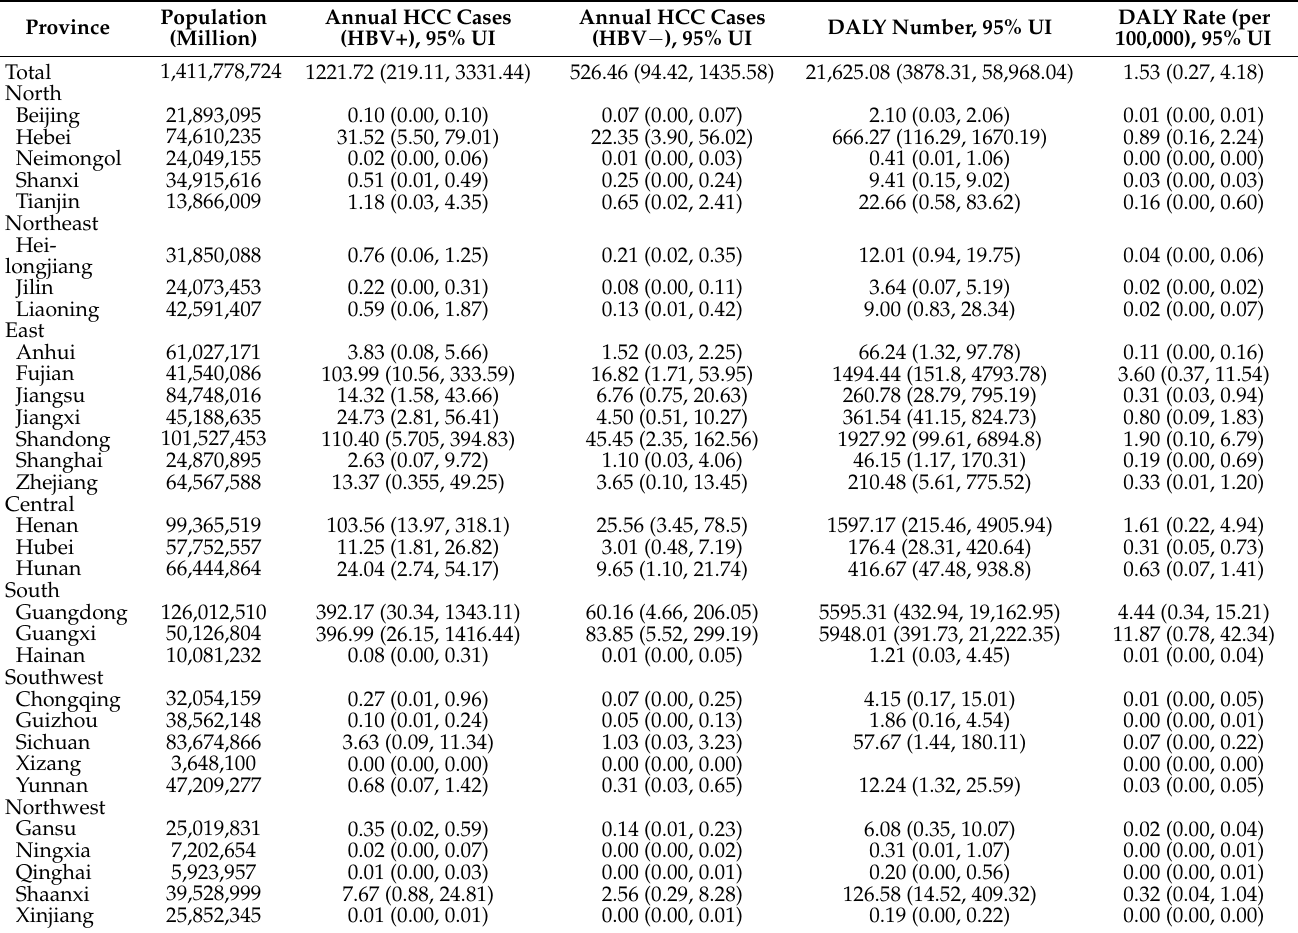
Table 5. Estimated DALY of HCC due to AFTs in China in